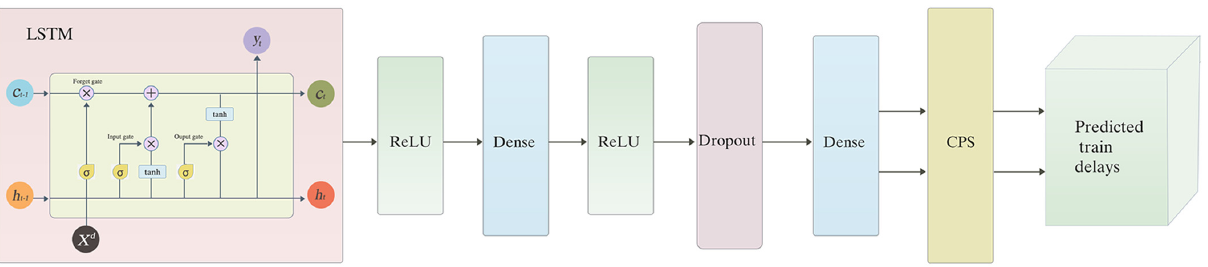
Figure 2. LSTM-CPS network topology.